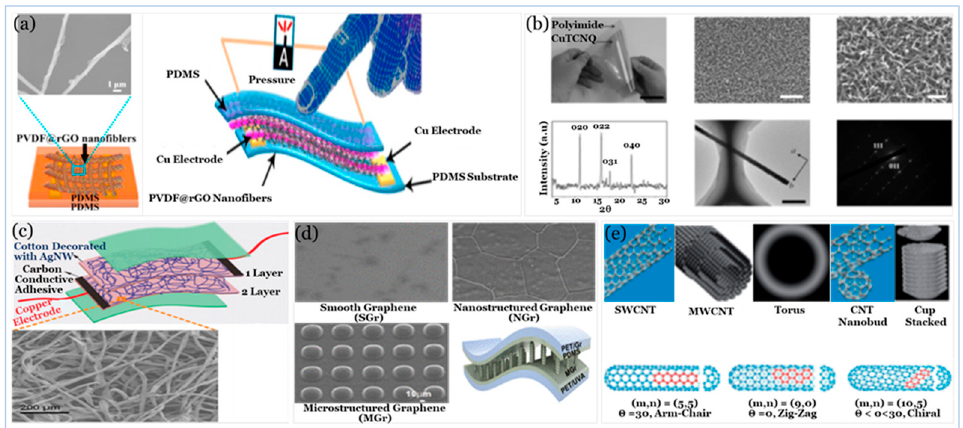
Figure 9. Conductive elements ( a ) Conducting Polymer. Reproduced with permission [251] Copyright